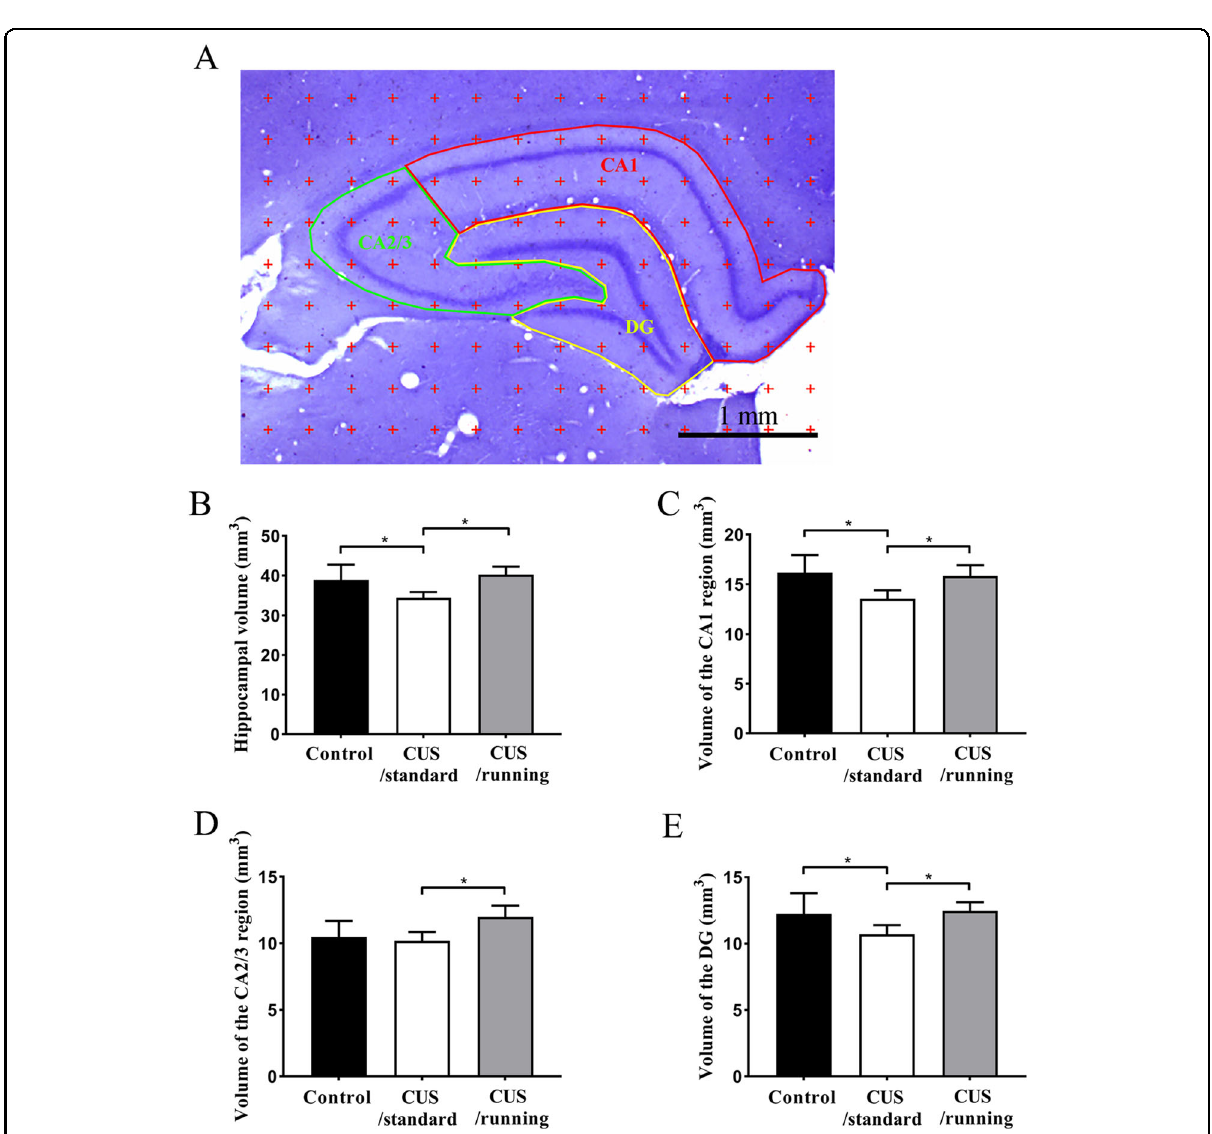
Fig. 2 Illustrations of the method used to quantify the hippocampal volume and the positive effects of running exercise on the hippocampal volume of CUS rats. A An illustration of the stereological method used to estimate the hippocampal volume. The points located on the whole hippocampus and its subregions were counted. Bar = 1 mm. B – E The volume of the total hippocampus, the CA1 region, the CA2/3 region and DG in the control group ( n = 5), the CUS/standard group ( n = 5), and the CUS/cunning group ( n = 5) (mean ± SD). Asterisk indicates p < 0.05. CUS chronic unpredictable